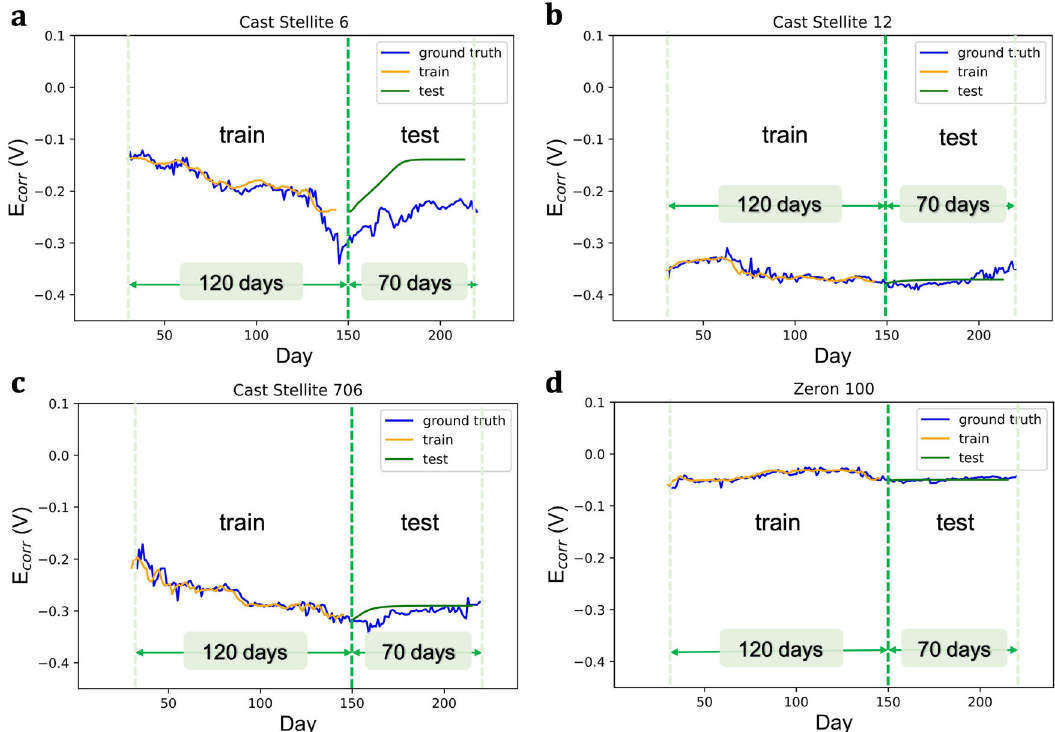
Fig. 8 The prediction of following 70 days ’ immersion by LSTM model. Prediction of the following 70 days of immersion by the LSTM model: a Cast Stellite 6, b Cast Stellite 12, c Cast Stellite 706, and d Zeron 100. LSTM long short-term memory, Ecorr free corrosion